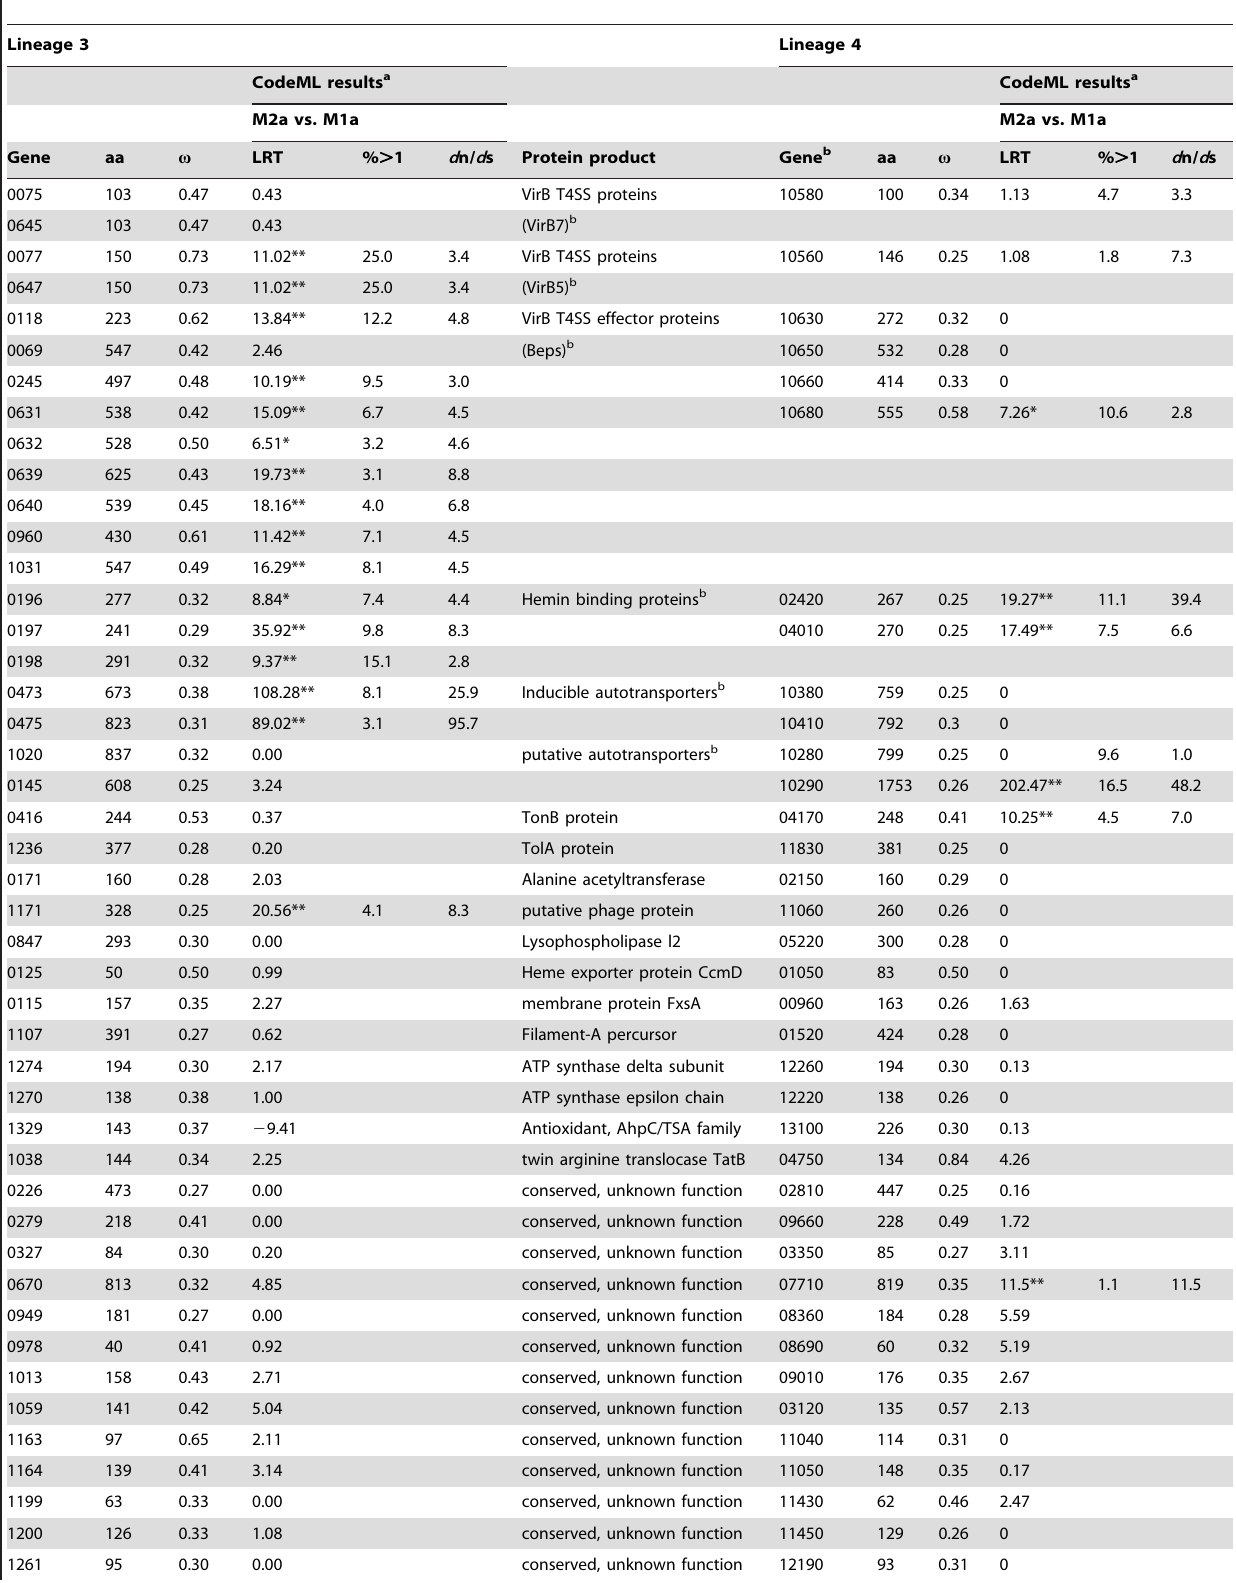
Table 3. Common genes of lineage 3 and lineage 4 with average d n/ d s values ( v ) $ 0.25 and results of the CodeML analysis.